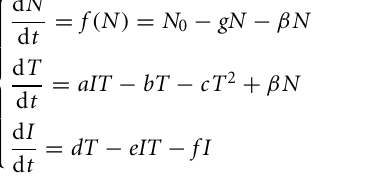
parameter: an immune response can be initiated for large values of k . However, due to hysteresis characteristic in this model, the immune response is not suppressed after decreasing T cell activation ( k ). Stable and unstable equilibrium points are shown by black and red lines,